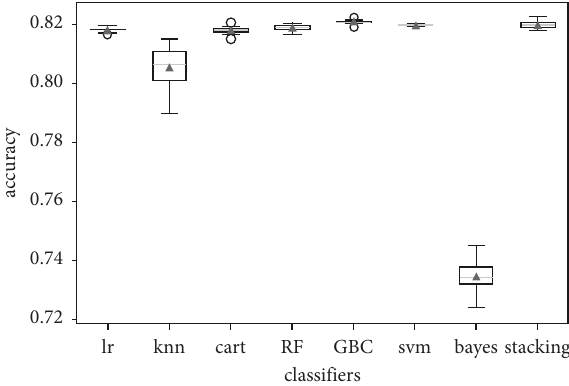
Figure 8: Comparing the performance of the seven classifers and the stacked